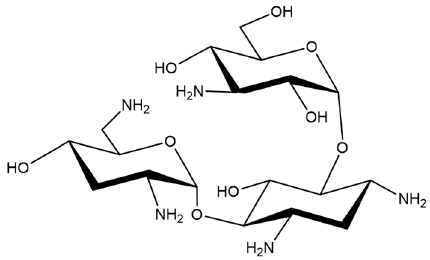
Figure 1. Chemical structure of Tobramycin.